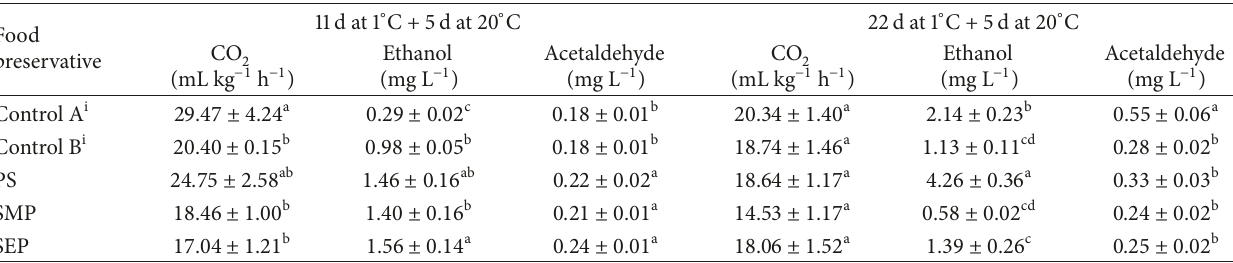
Table 3: CO 2 production rate and ethanol and acetaldehyde content in the juice of “Friar” plums uncoated or coated with hydroxypropyl methylcellulose-beeswax edible coatings containing potassium sorbate (PS), sodium methyl paraben (SMP), or sodium ethyl paraben (SEP) and stored at 1 ∘ C for 11 or 22 d followed by 5d at 20 ∘